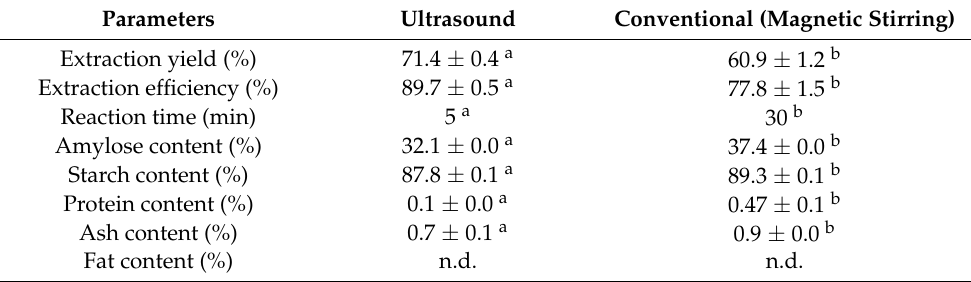
Table 1. Comparison between conventional and ultrasound-assisted